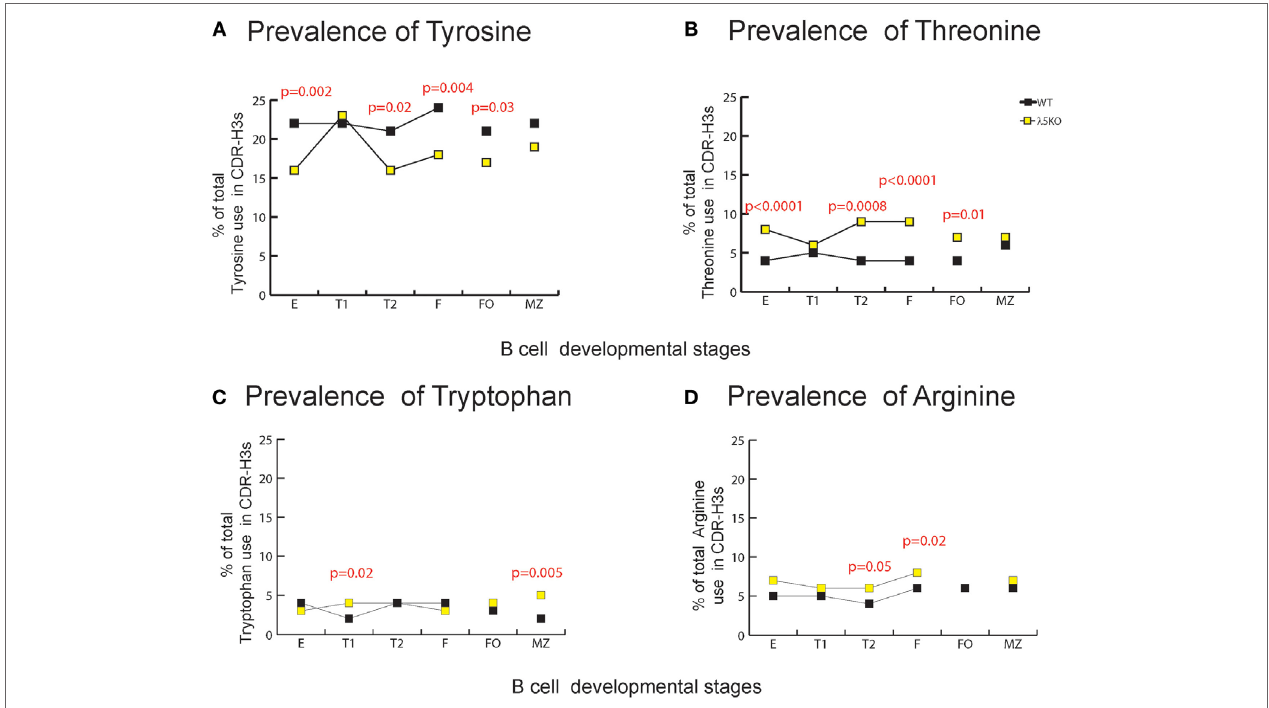
FigUre 4 | Representation of CDR-H3 amino acids important for protein–protein interaction in λ 5KO versus wild-type (WT). Prevalence of (a) tyrosine, (B) threonine, (c) tryptophan, and (D) arginine amino acid expressed in CDR-H3 loop sequences obtained from λ 5KO versus WT mice in selected B cell subsets. The p -values for differences that achieved statistical significance ( p ≤ 0.05) are shown.